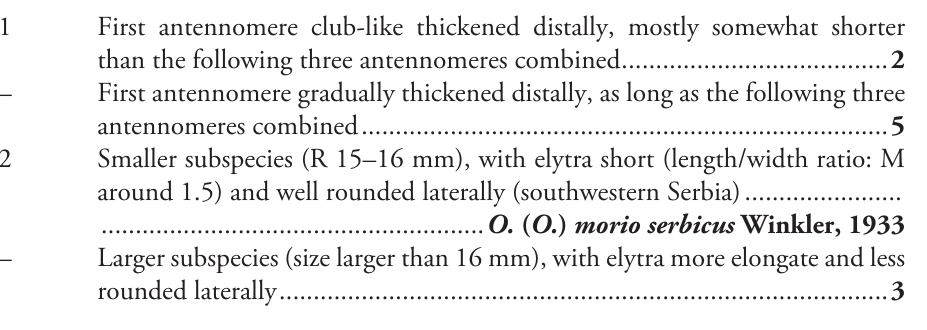
Larger subspecies (size larger than 16 mm), with elytra more elongate and